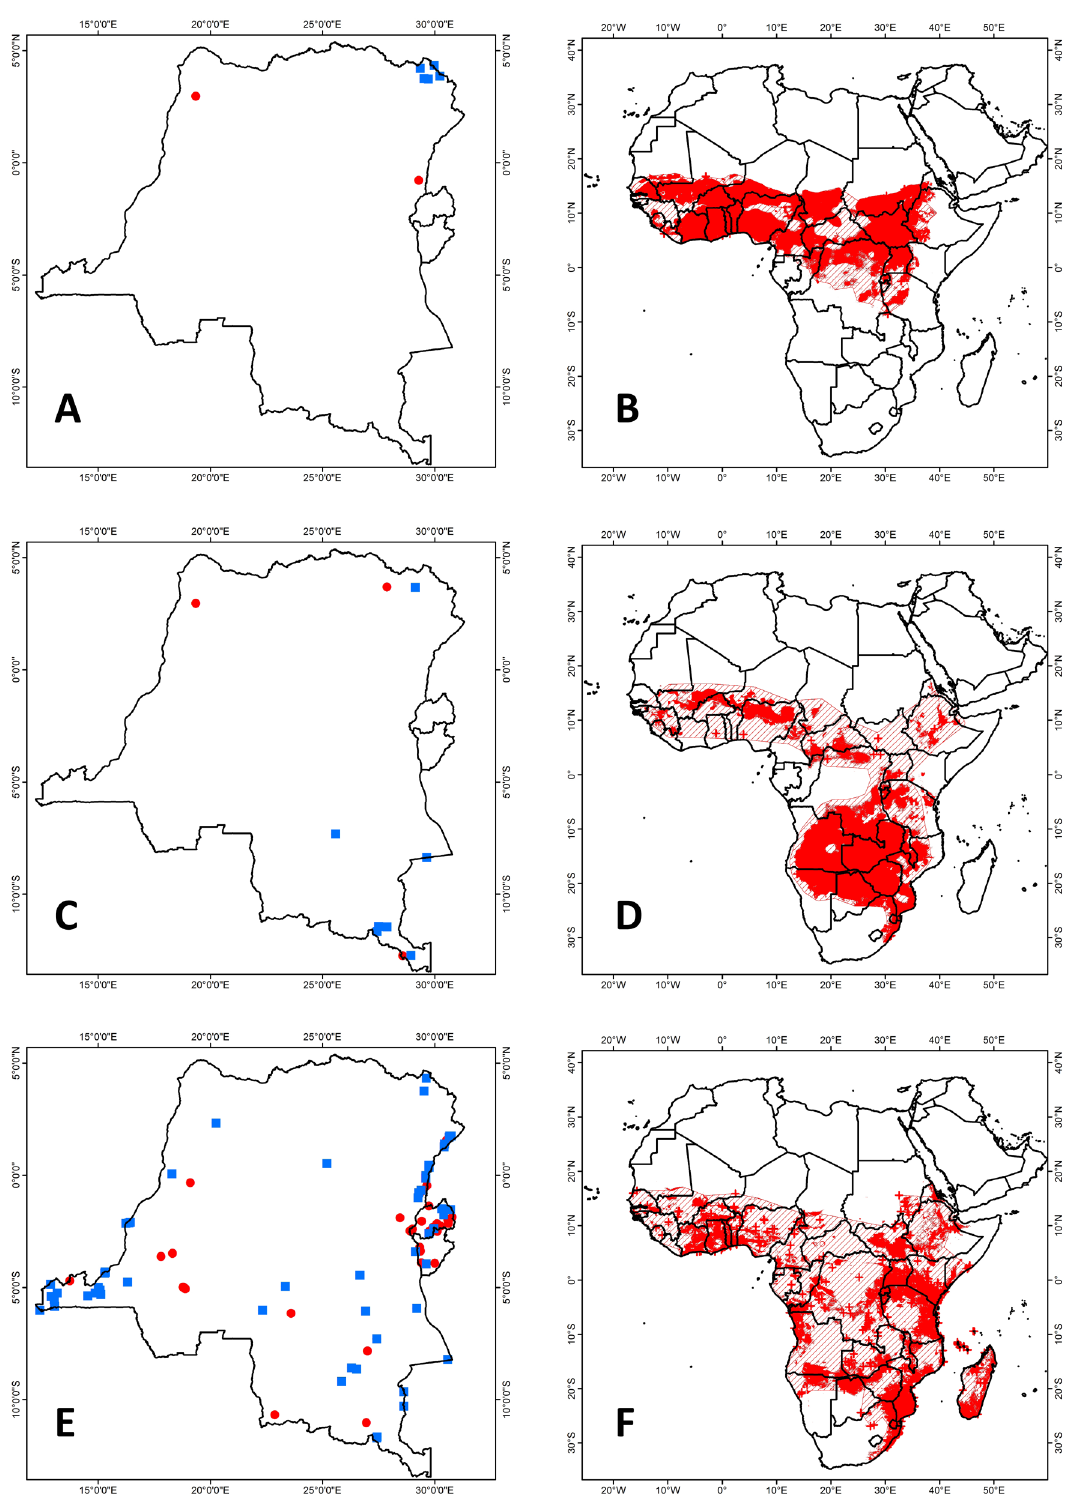
Fig. 26. Distribution maps. A–B . Chaerephon major (Trouessart, 1897). C–D . Chaerephon